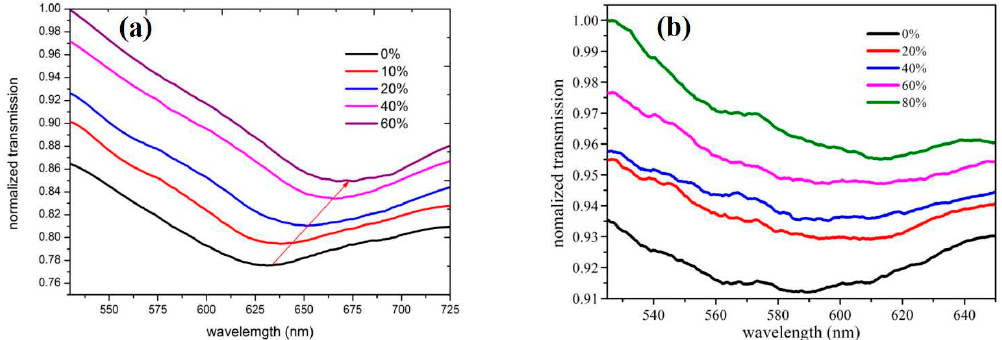
Figure 3. ( a ) The SEM of new D-shape area morphology. ( b ) The SEM image of the D-type area. ( c ) The SEM image of the gold film. ( d ) 10 groups of fixed-point scanning Raman spectra on the same sample. ( e ) The SEM image of grown graphene. ( f ) The SEM image of graphene folds after magnification.